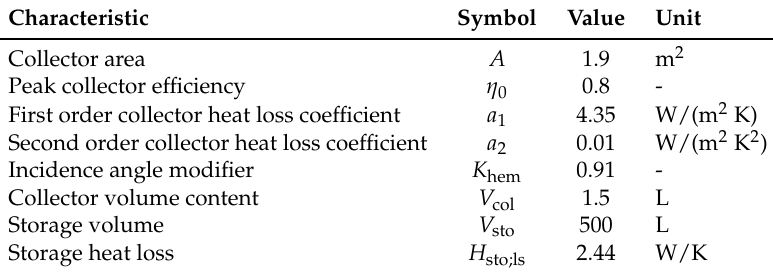
Figure 5. Monthly balance from f -chart-based method simulation. Useful solar energy: min ( Q sol;loop;out ; Q sto;out ) . Remaining DHW need: max ( Q sto;out − Q sol;loop;out ;0 ) . Excess solar energy: max ( Q sol;loop;out − Q sto;out ;0 ) . Table 2. Main component